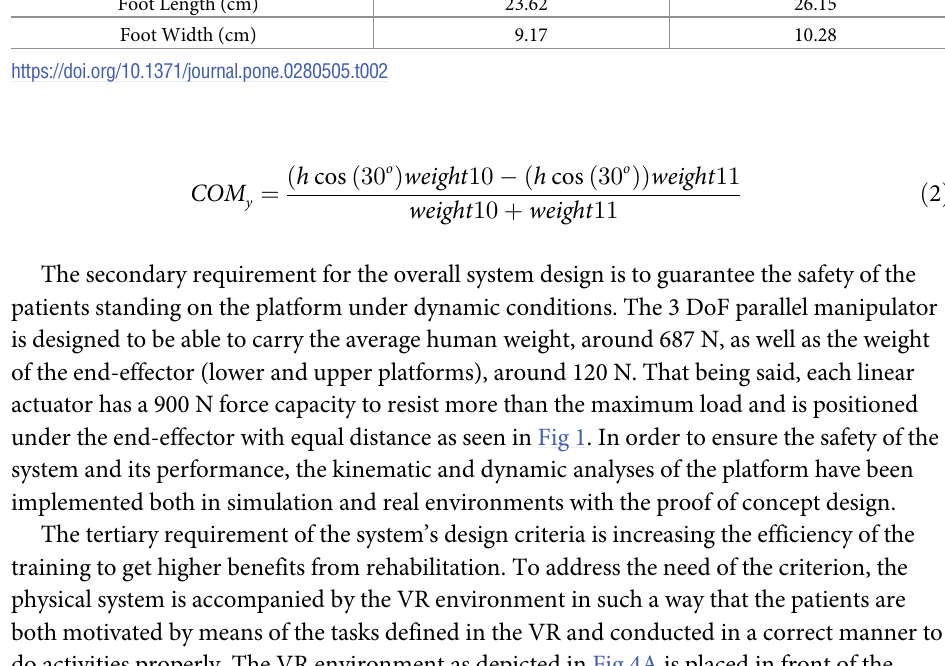
PLOS ONE | https://doi.org/10.1371/journal.pone.0280505 February 24,